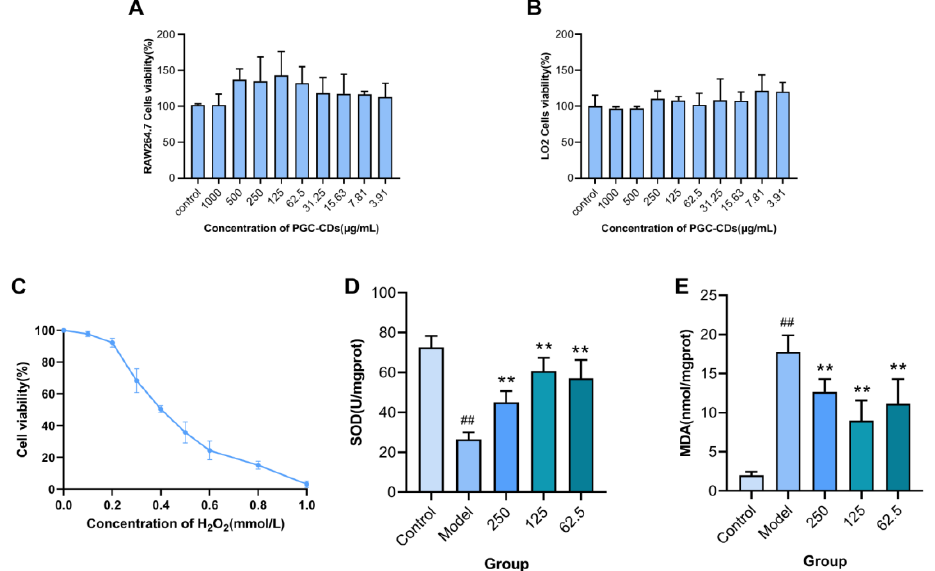
Figure 4. Effects of PGC-CDs on the viability and oxidative stress of cells. ( A ) Effects of various concentrations of PGC-CDs on RAW264.7 cells viability. ( B ) Effects of various concentrations of PGC-CDs on LO2 cells viability. ( C ) Dose-dependent effects of H 2 O 2 on the viability of RAW264.7 cells. Effects of PGC-CDs on SOD ( D ) and MDA I in RAW264.7 cells with H 2 O 2 -induced model. They were divided into control group (Control), model group (Model), and 250 (250), 125 (125) and 62.5 (62.5) µ g/mL of PGC-CDs groups, n = 6. Compared with the control group, ## p < 0.01. Compared with the model group, ** p < 0.01.